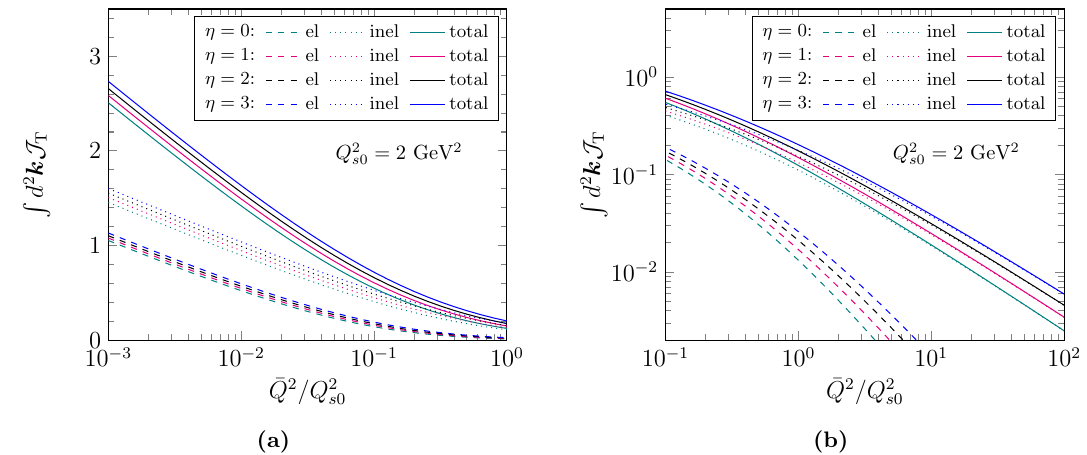
Figure 9. SIDIS cross-sections integrated over k and their high-energy evolution up to η = 3 : the elastic, inelastic and total cross-sections are plotted in terms of ¯ Q 2 /Q 2 the rapidity η . (a) Logarithmic increase at low ¯ Q 2 : elastic and inelastic cross-sections are still comparable with each other. (b) Power law behaviour at high ¯ Q 2 : inelastic scattering strongly dominates the total